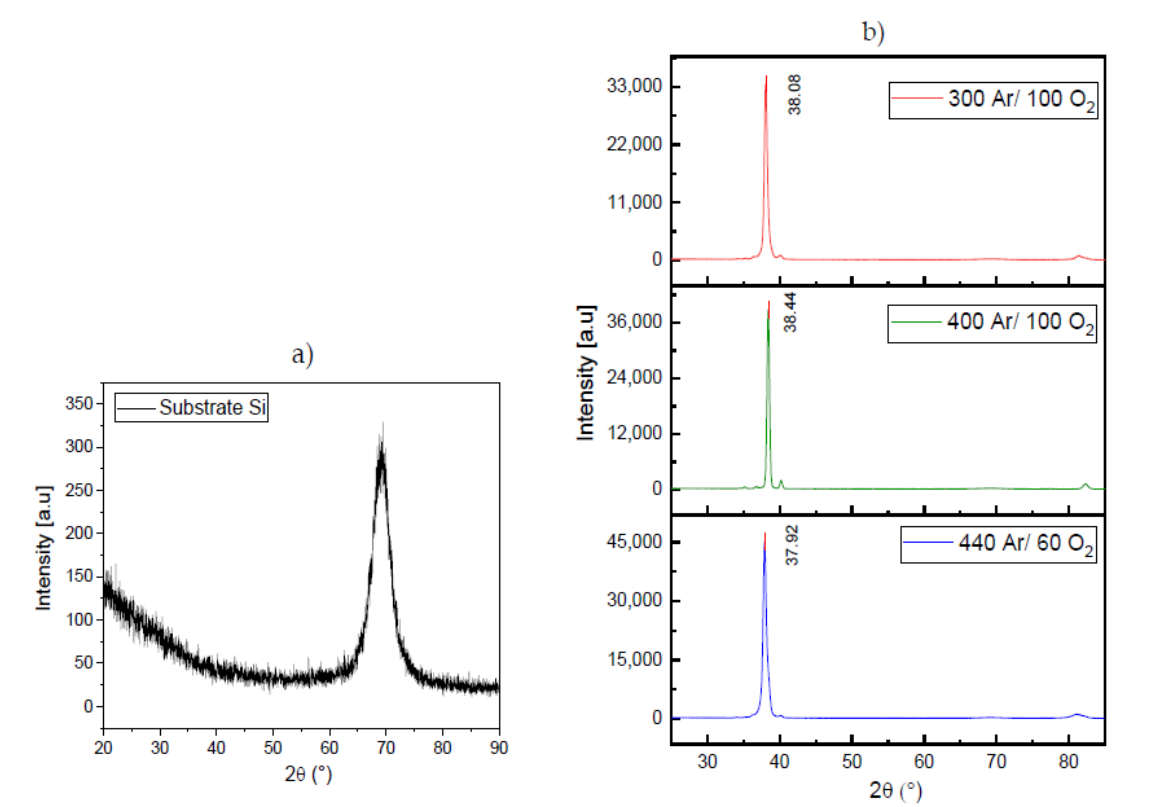
Figure 1. X-ray diffraction patterns of ( a ) silicon substrate and ( b ) TiO x arc-PVD coatings deposited using different Ar/O 2 flow ratios.